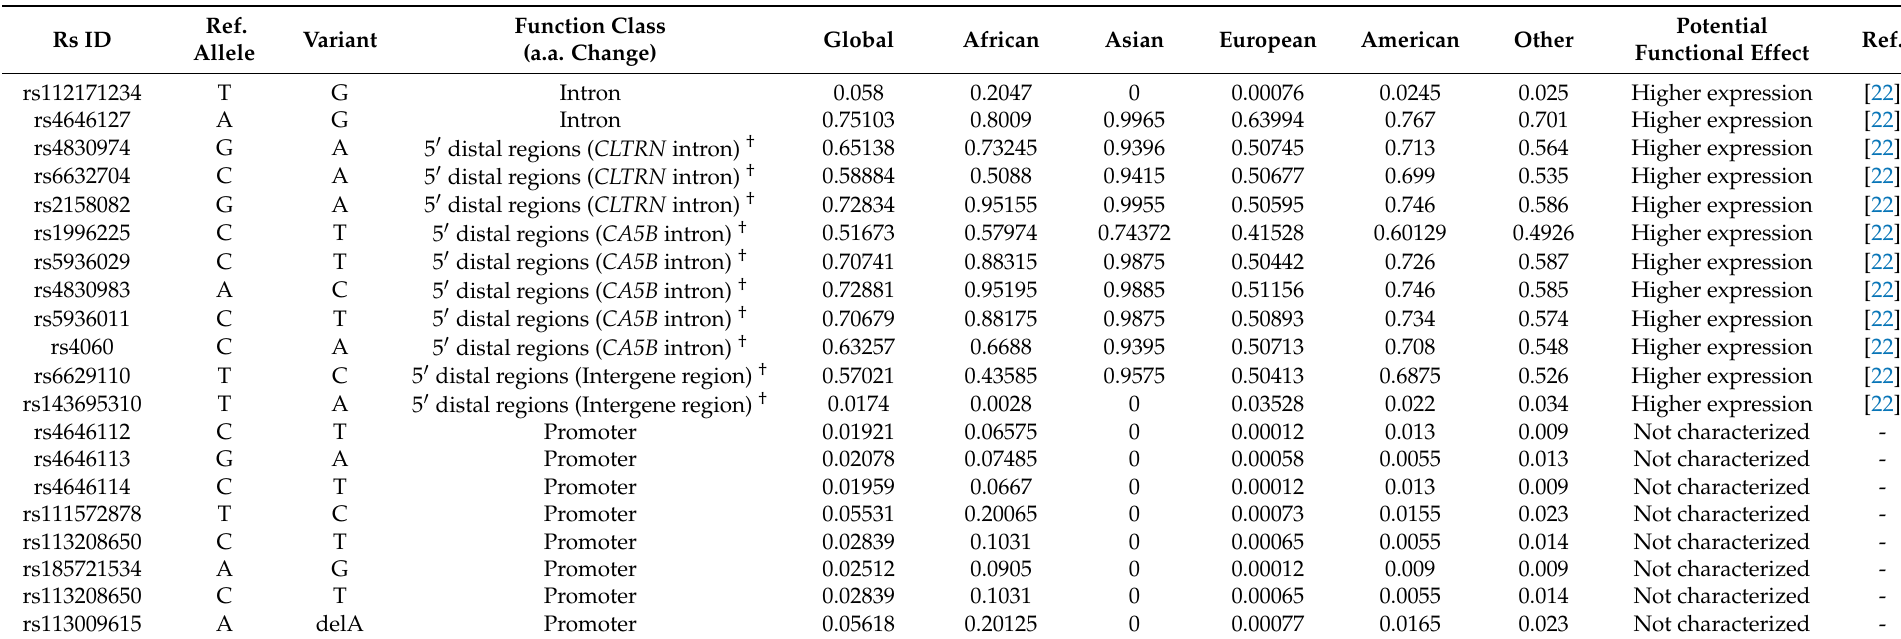
Table 1. Summary of population allele frequencies of host protein genetic variants related to ACE2 protein